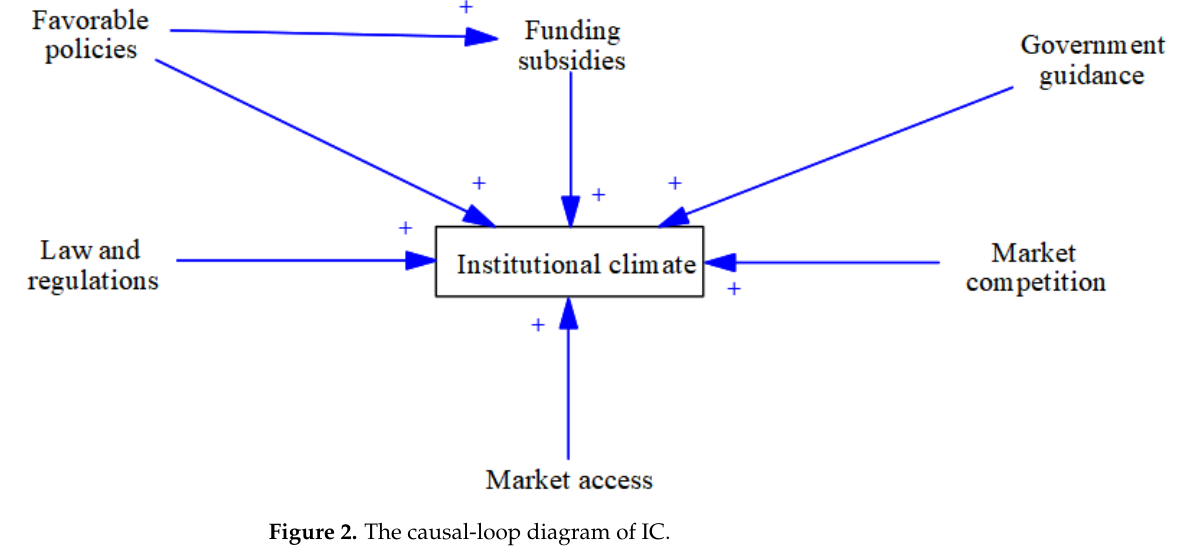
Figure 2. The causal-loop diagram of IC.